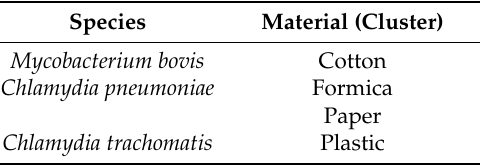
Table 5. Survival of other